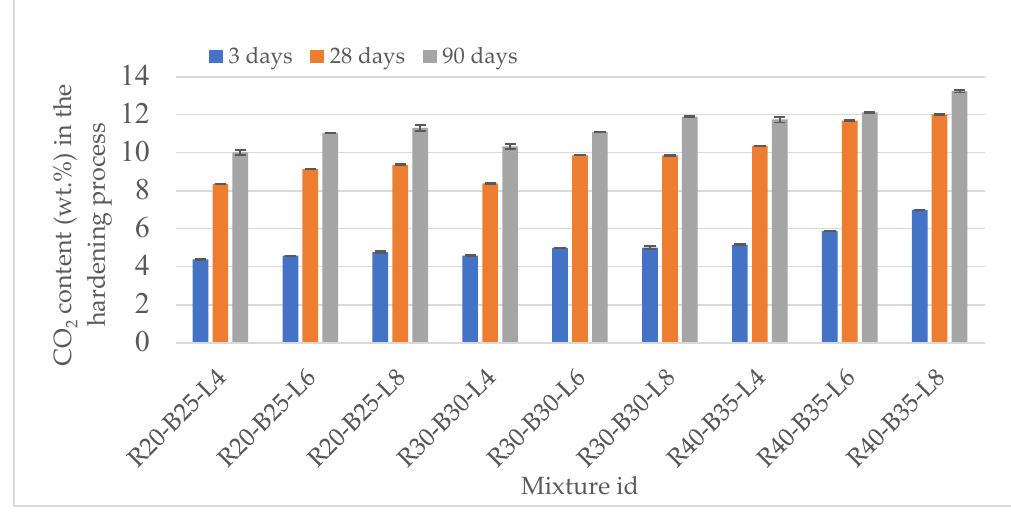
Figure 9. Change in the carbonate content of materials.